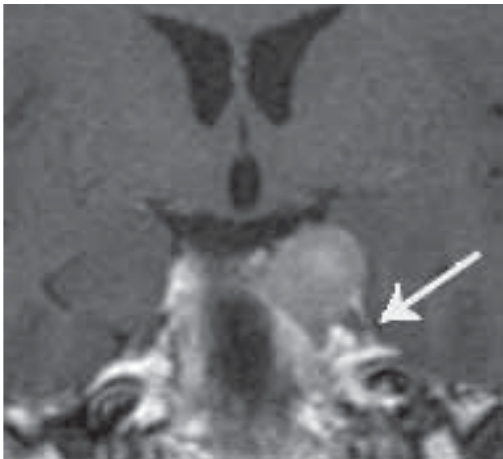
FIGURE 11. The coronal contrast-enhanced T1-weighted im- age shows a homogeneously enhancing sellar and left para- sellar mass with a dural tail sign. The lesion corresponds to a pituitary macro-adenoma.